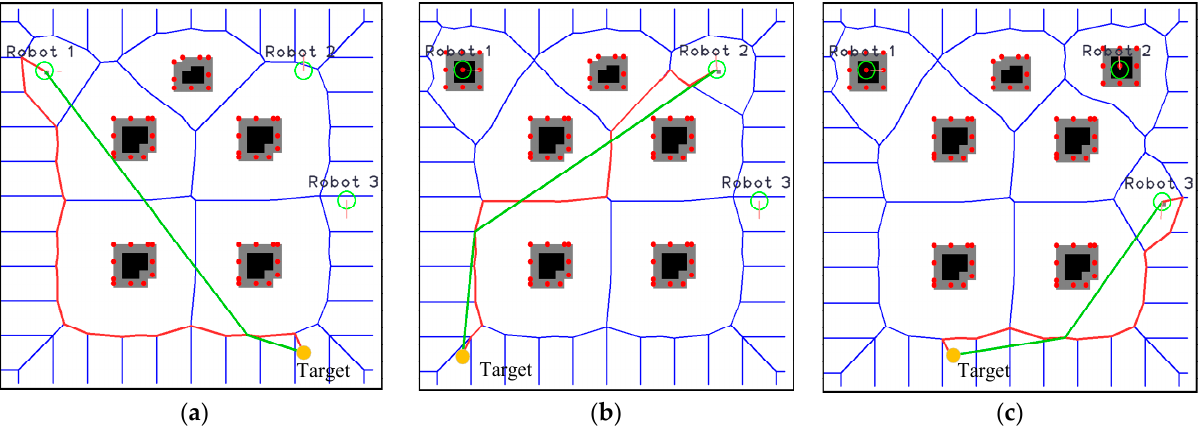
Figure 6. ( a ) Path planning for robot-1 (the red line is the shortest path based on the GVD, and the green line is the result of path planning), ( b ) path planning for robot-2, and ( c ) path planning for robot-3.